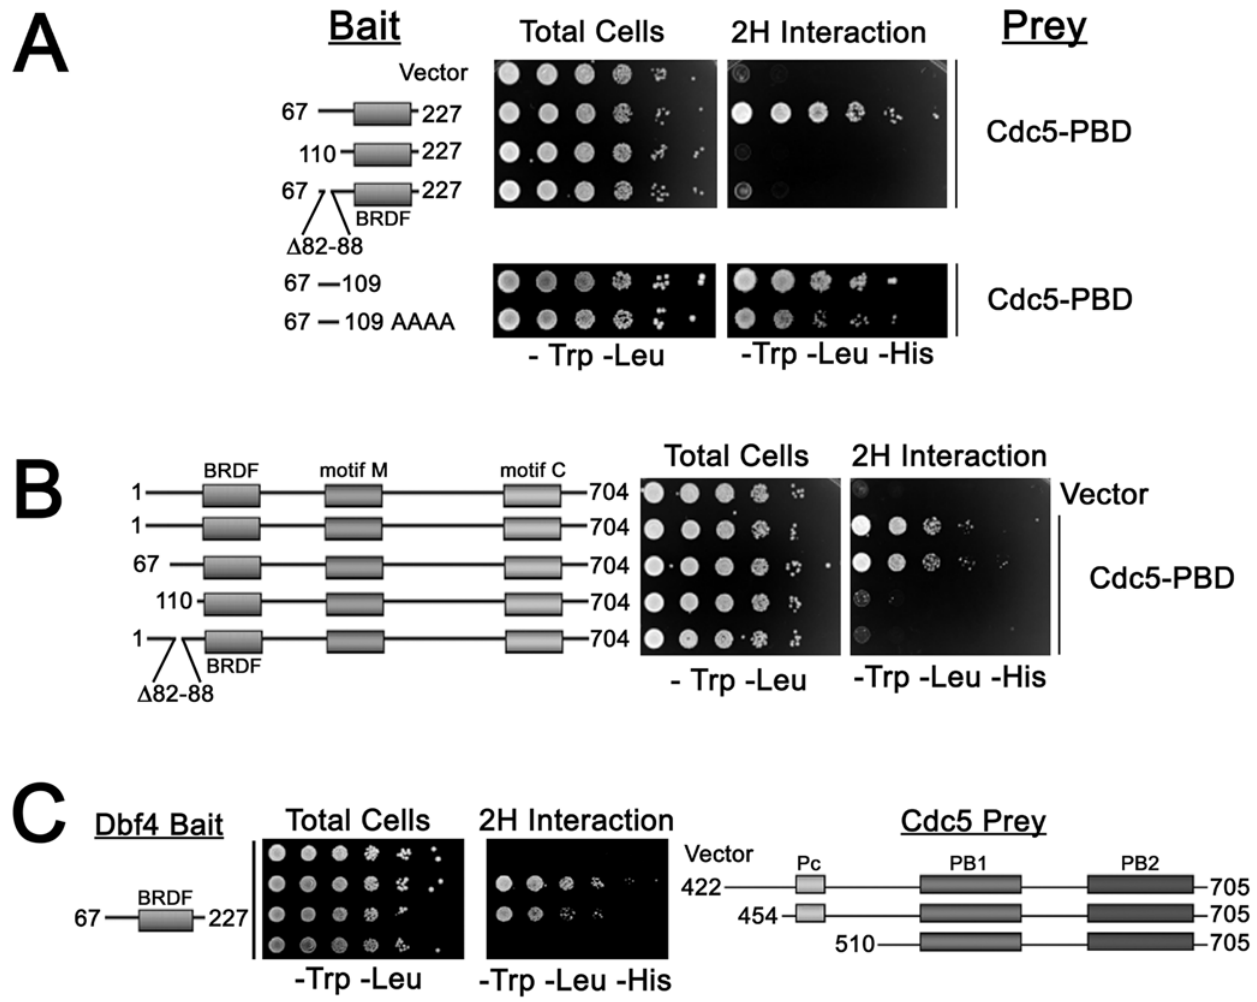
Figure 1. The N-terminus of Dbf4p interacts with the Polo PBD. Cells co-transformed with various bait GAL4 DNA binding domain fusions (GBD- DBF4 ) and prey GAL4 activation domain fusions (GAD- CDC5 ) constructs were spotted at 10-fold serial dilutions on SCM–Trp –Leu and SCM–Trp– Leu–His plates containing 2 mM 3AT (A, C) or 0.5 mM 3AT (B) and incubated at 30 u C for 2 to 3 days. The GBD-Dbf4 protein levels are shown in Figure